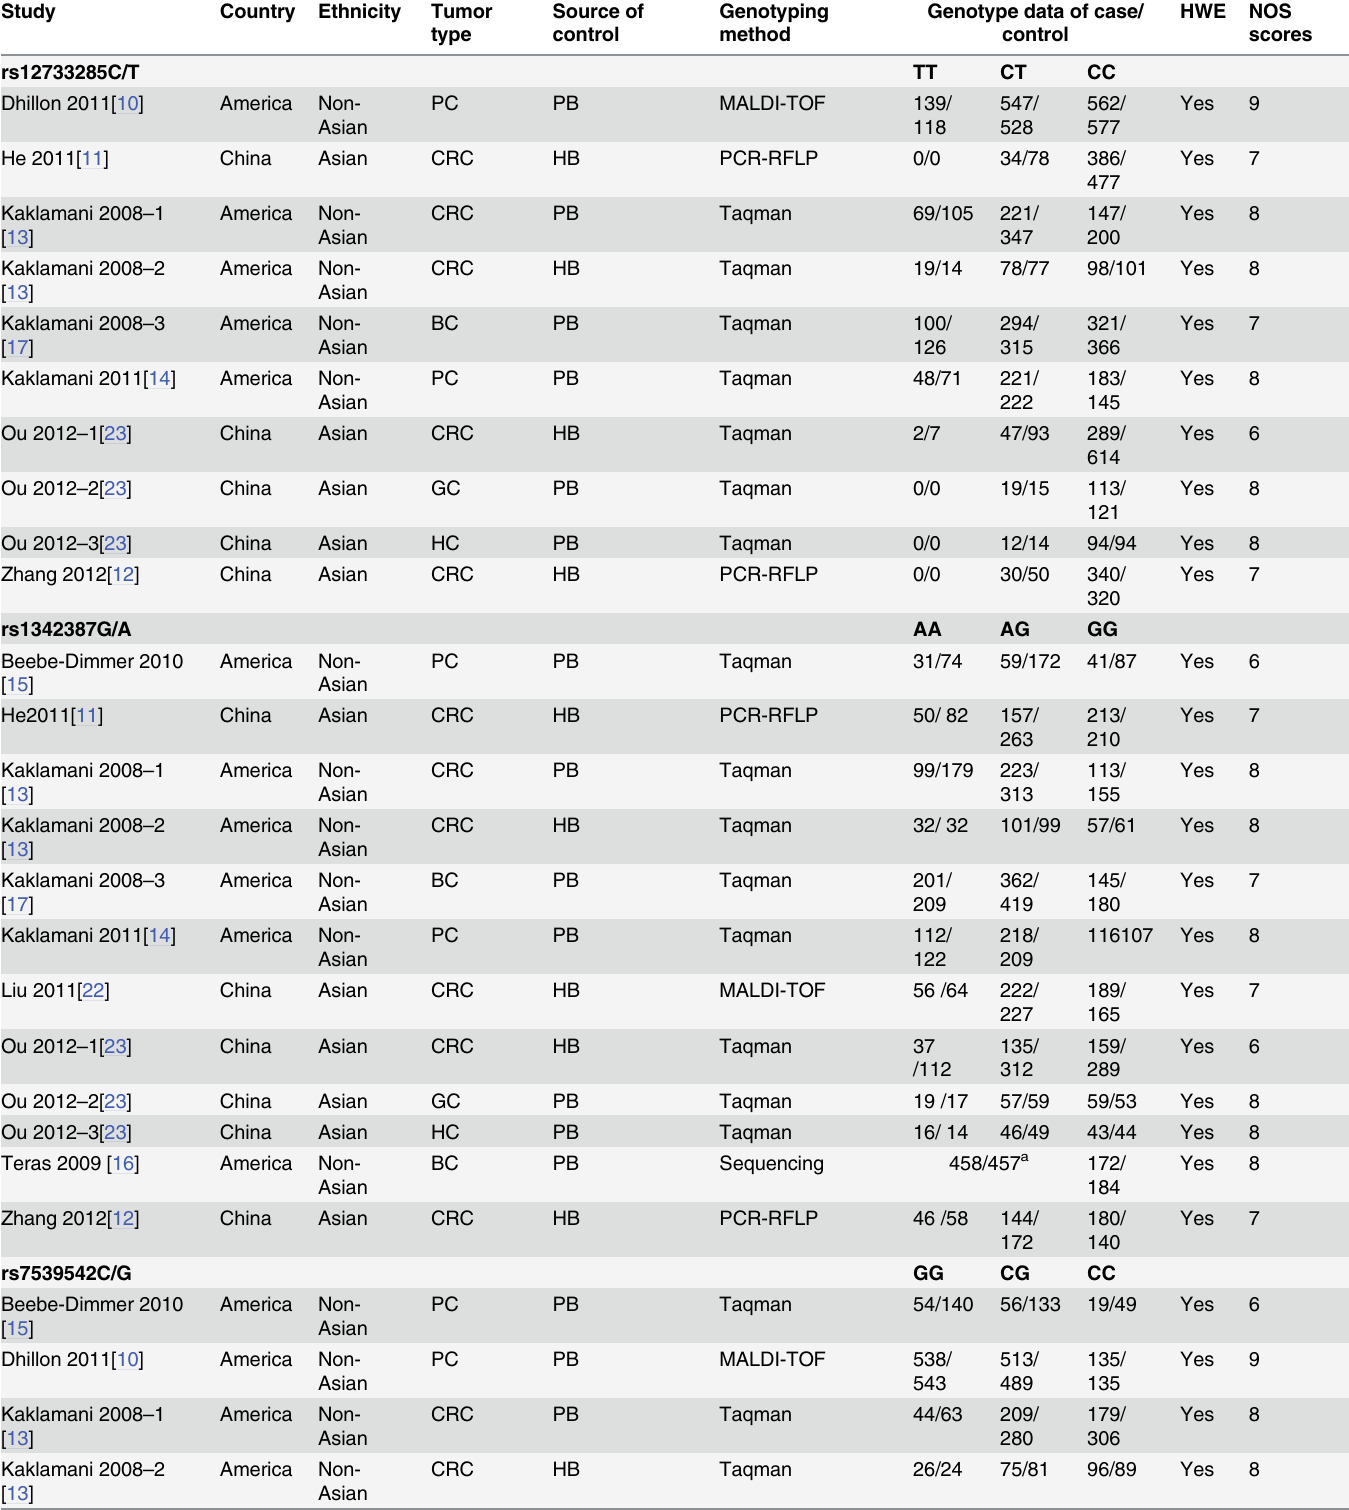
Table 1. Characteristics of studies included in the